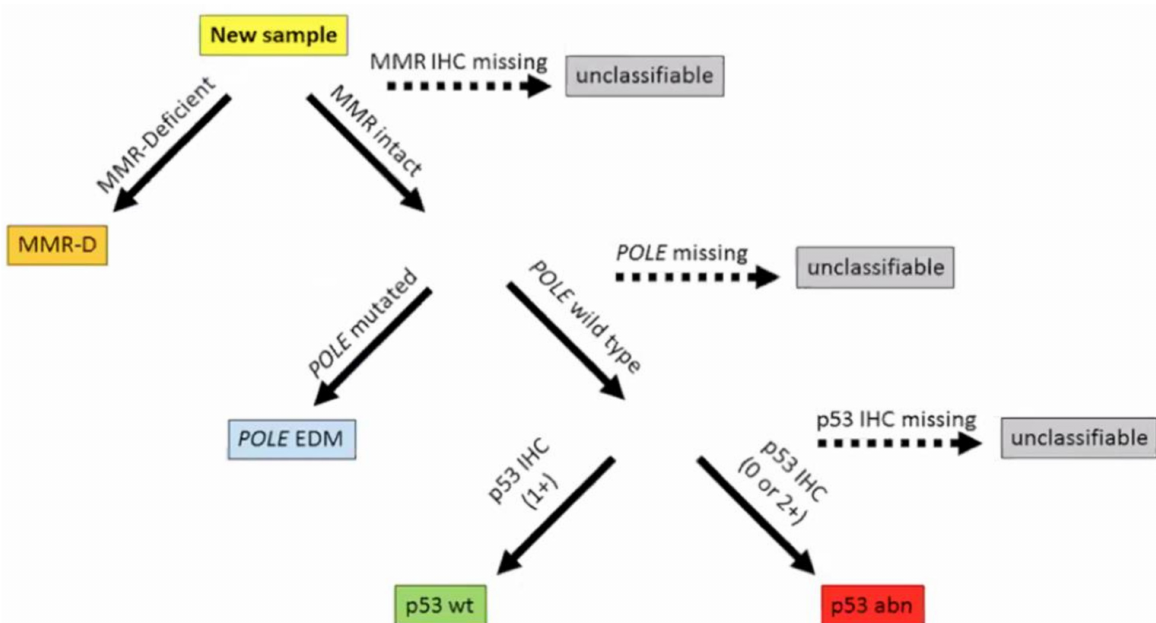
Figure 2. The ProMisE (Proactive Molecular Risk Classifier for Endometrial Cancer) original molecu- lar classification. Reprinted with permission from “Confirmation of ProMisE: A simple, genomics- based clinical classifier for endometrial cancer” [19]. MMR-D mismatch repair deficiency, POLE EDM polymerase epsilon exonuclease domain mutation, IHC immunohistochemistry, wt wild type, abn abnormal. p53 IHC intensity as absent (0) or overexpressed (+2) is classified as p53 abn, whereas some level of p53 IHC expression (+1) is interpreted as p53 wt